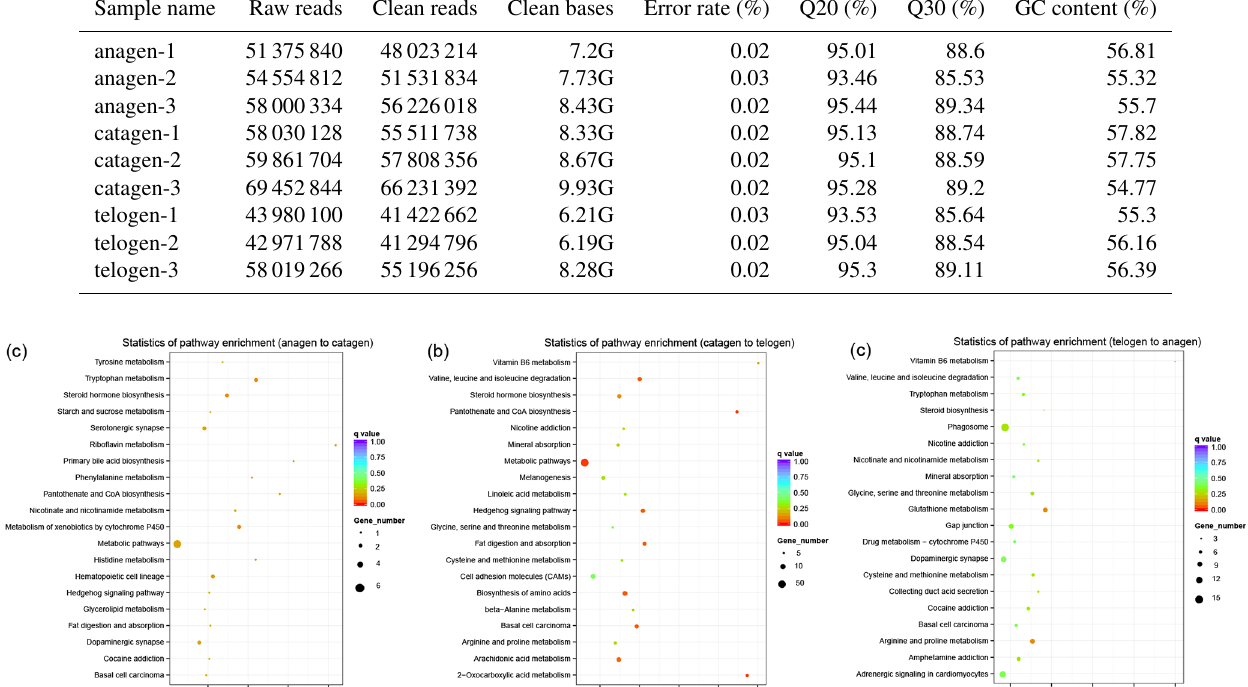
Table 1. RNA-Seq quality control result.